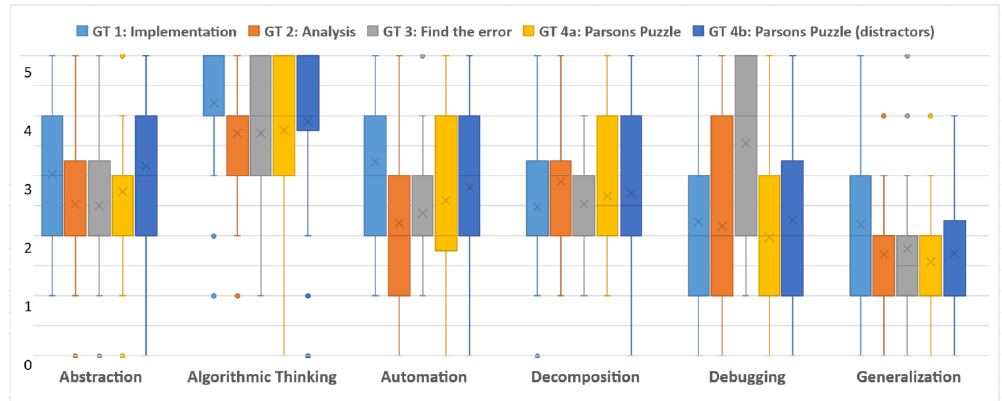
Figure 4. Summary of the experts’ evaluations of the GTs regarding the six core computational thinking (CT) skills [8] on a six-point Likert scale from 0 (not addressed at all) to 5 (very strongly addressed). The symbol × marks the arithmetic